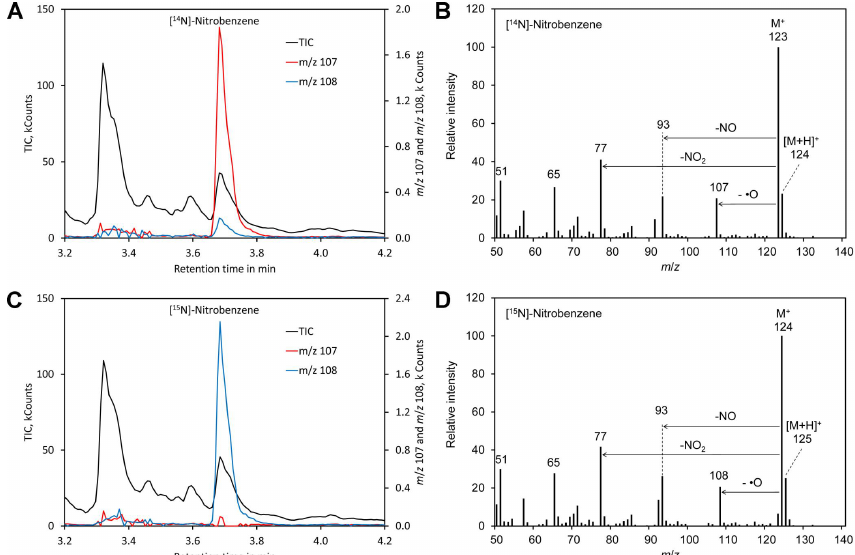
Figure 2. Derivatization with benzene. ( A ) Chromatogram obtained by derivatization of [ 14 N]-nitrate. ( B ) Mass spectrum of the derivatization product [ 14 N]-nitrobenzene. ( C ) Chromatogram obtained by derivatization of [ 14 N]-nitrate. ( D ) Mass spectrum of the derivatization product [ 14 N]-nitrobenzene. Original data are included in Supplementary File S2.